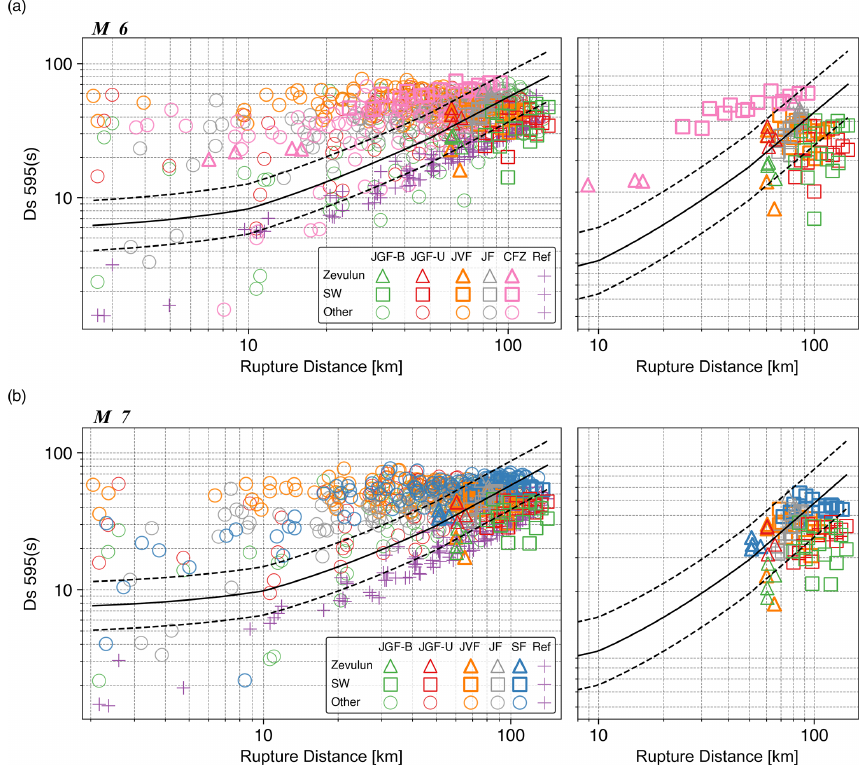
Figure 10. The 5% to 95% ground motion significant duration ( D s 595) comparison between simulated and empirical GMMs (Afshari and Stewart, 2016) for bilateral rupture on the Jordan Gorge Fault (JGF-B), Jericho Fault (JF), Carmel Fault Zone (CFZ; for M 6), and Shemona Fault (SF; for M 7), a southward unilateral rupture on the JGF (JGF-U), and a super-shear rupture on the Jordan Valley Fault (JVF) for M 6 (a) and M 7 (b) . Main plots (left) accompanied with subplots showing only the records from the Zevulun Valley and the sedimentary wedge (right). Solid and dashed lines represent the median and the standard deviation of the empirical GMM, respectively. The records from Zevulun Valley and the sedimentary wedge (SW) are marked with triangles and rectangles, respectively. The other records are marked with